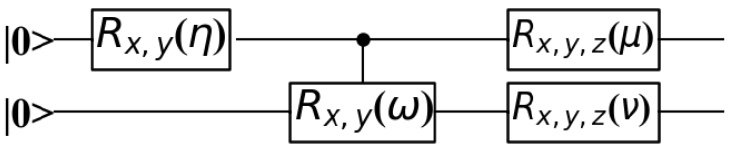
Figure 5. Two-qubit quantum circuit to generate partial entanglement between the two qubits with 0 ≤ concurrence ≤ 1. The gates are the rotation operators. Concurrence = 0 for separable states and 1 for maximally entangled states (MES). For this circuit, concurrence = sin( η ) sin( ω / 2) and sin η is the degree of initial superposition of the control qubit.